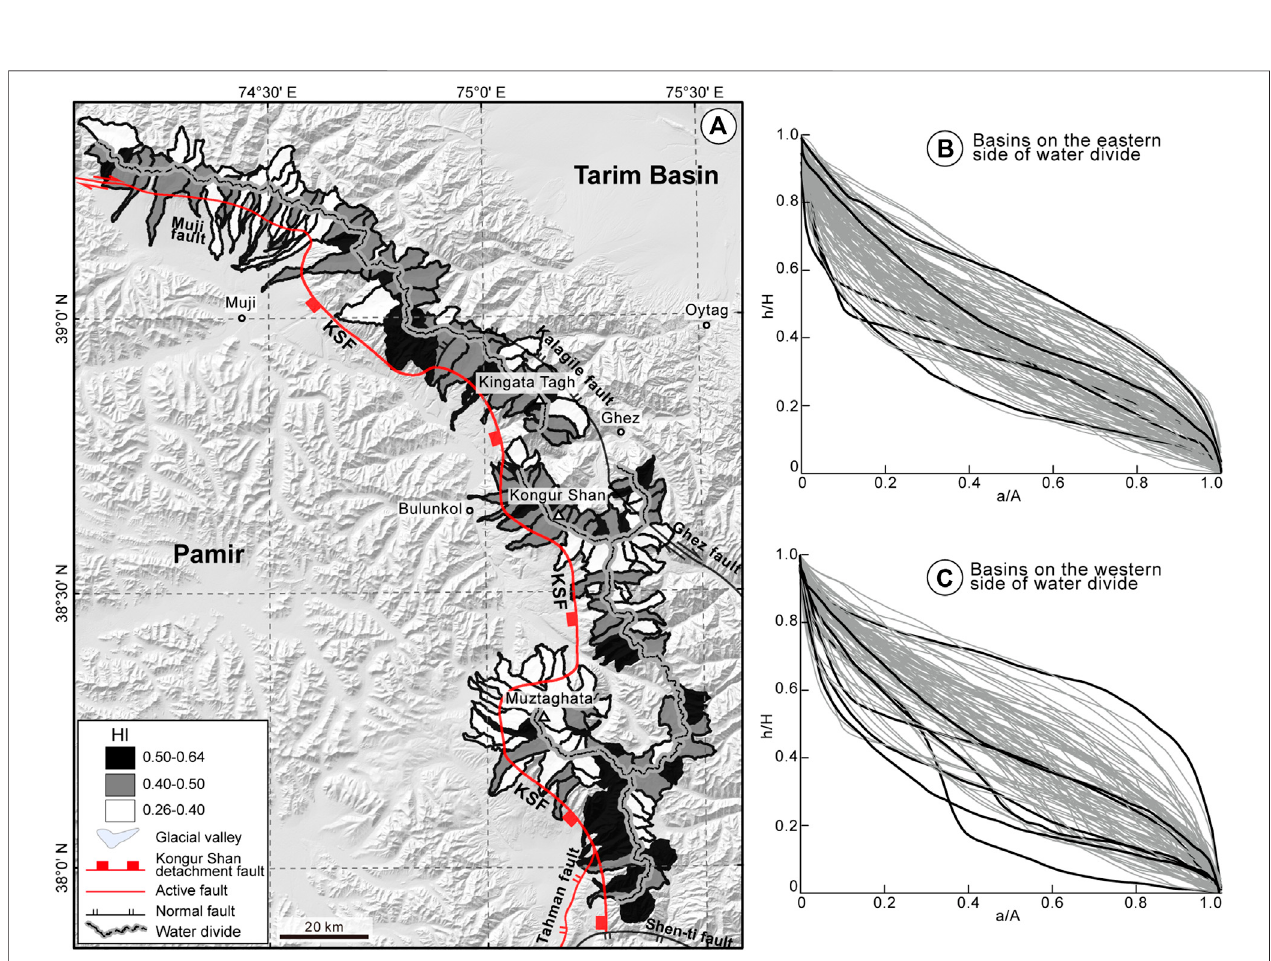
FIGURE 3 | Spatial distribution of HI values and hypsometric curves in eastern Pamir domes region. (A) Spatial map of HI values along water divide; (B,C) Hypsometric curves on eastern and western sides of divide, with typical curves in bold.